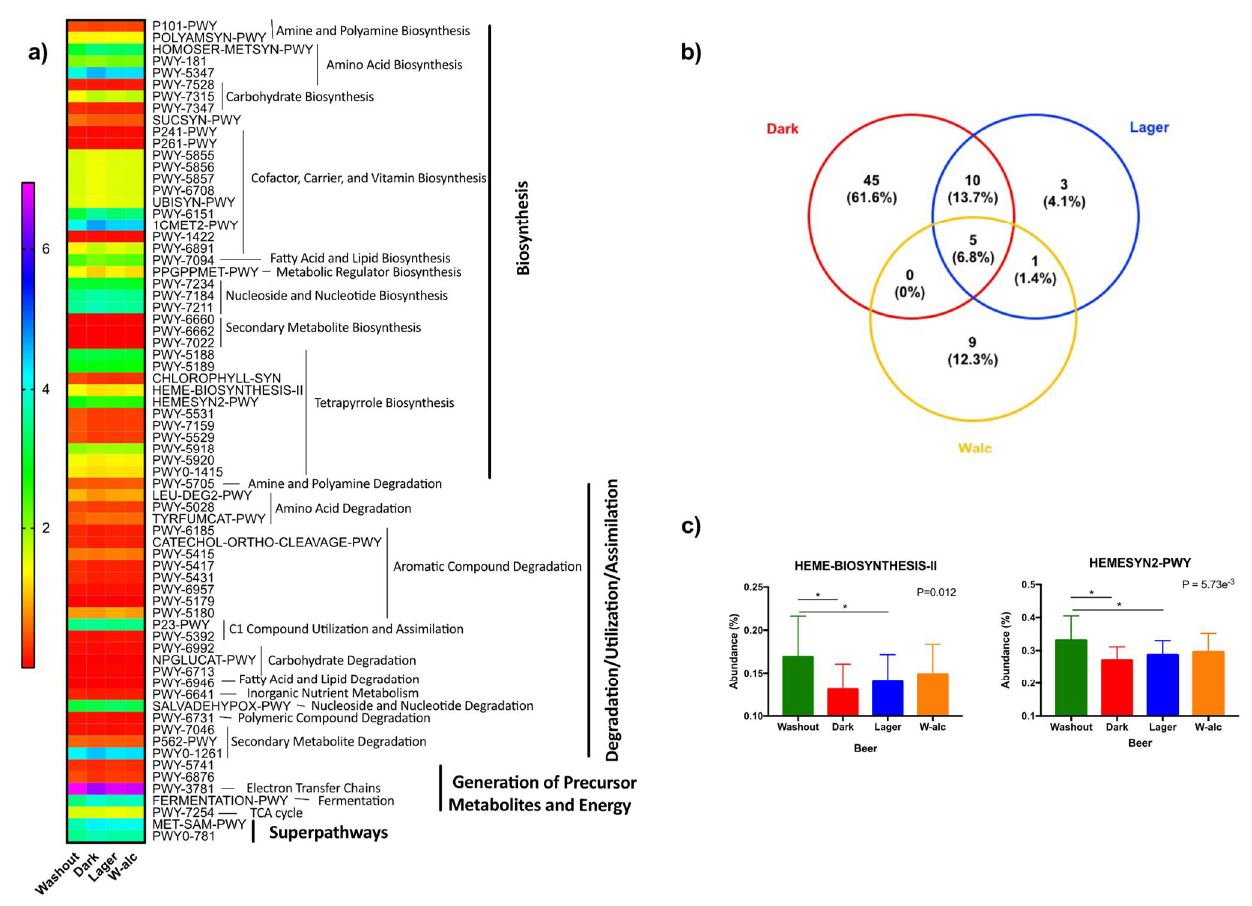
Figure 4. Predictive metabolic pathways by PICRUst2. ( a ) Differentially abundant Metacyc pathways identified after the intervention periods (mean values are presented. Supplemental Table S2 shows each pathway names). ( b ) Venn diagram of the Metacyc pathways that differed between the washout and each beer period (Supplemental Table S3 shows pathways shared and not shared by the different beer periods). ( c ) Porphyrin metabolism and heme biosynthesis routes in the washout period and after the consumption of the different types of beers. Values are presented as mean ± SD (standard deviation). * Statistically significant differences between groups ( p < 0.05).